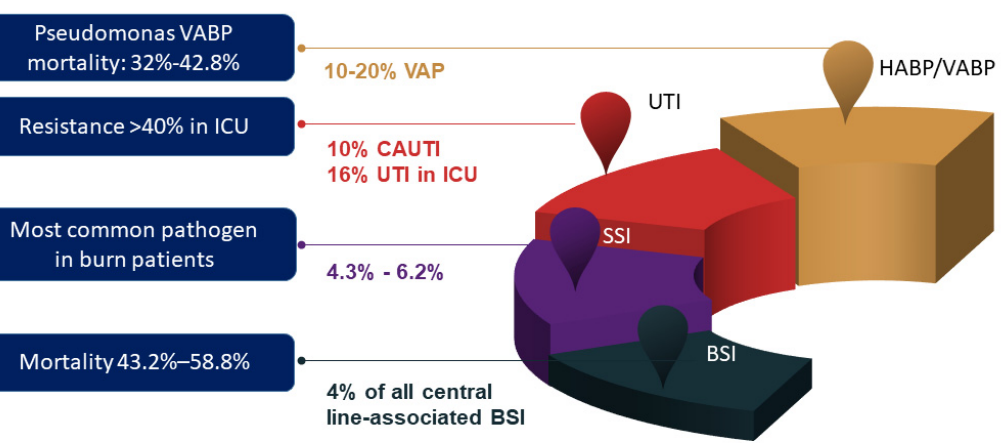
Figure 2. Most common healthcare–associated infections caused by P. aeruginosa [13]. Abbreviation: BSI, bloodstream infection; CAUTI, catheter-associated urinary tract infection; UTI, urinary tract infection; ICU, intensive care unit; HAP, hospital-acquired pneumonia; SSI, surgical site infection, VAP, ventilator-associated